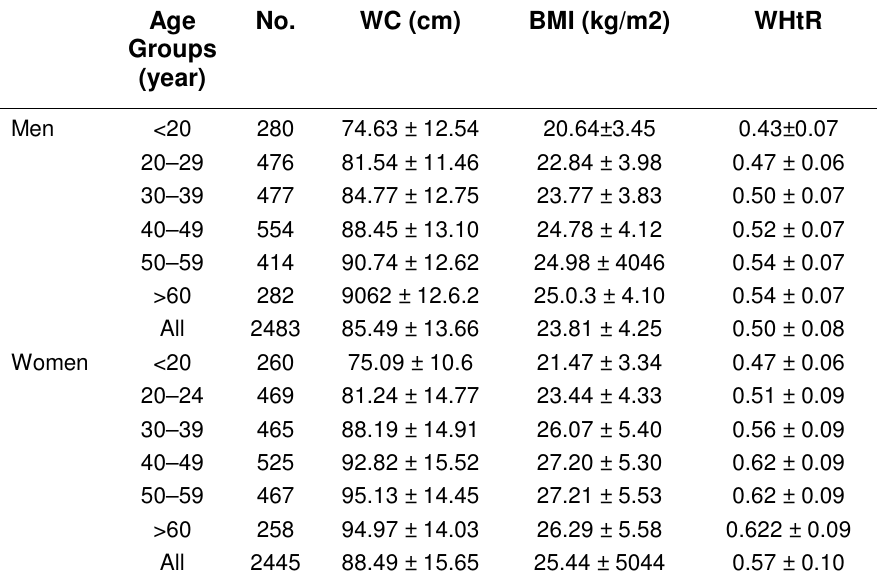
WHtR BMI (kg/m2) WC (cm) No.